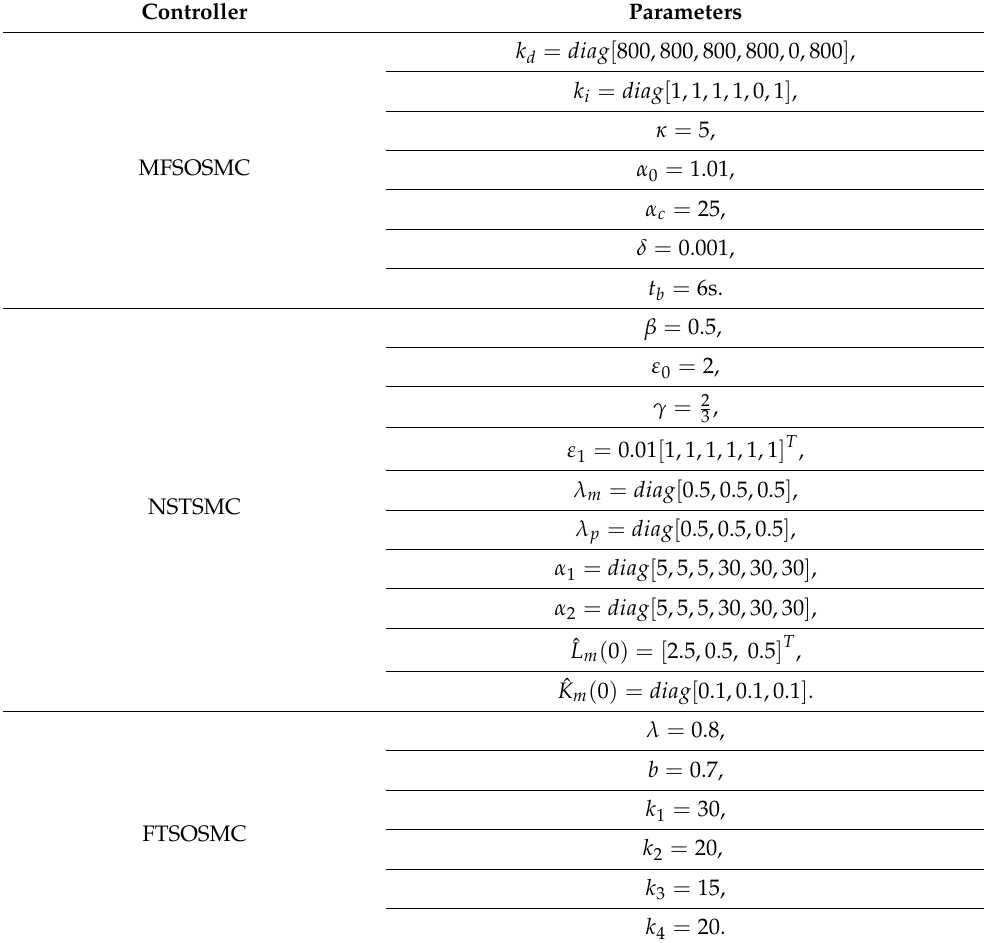
Table 6. Parameters used for simulation of the three